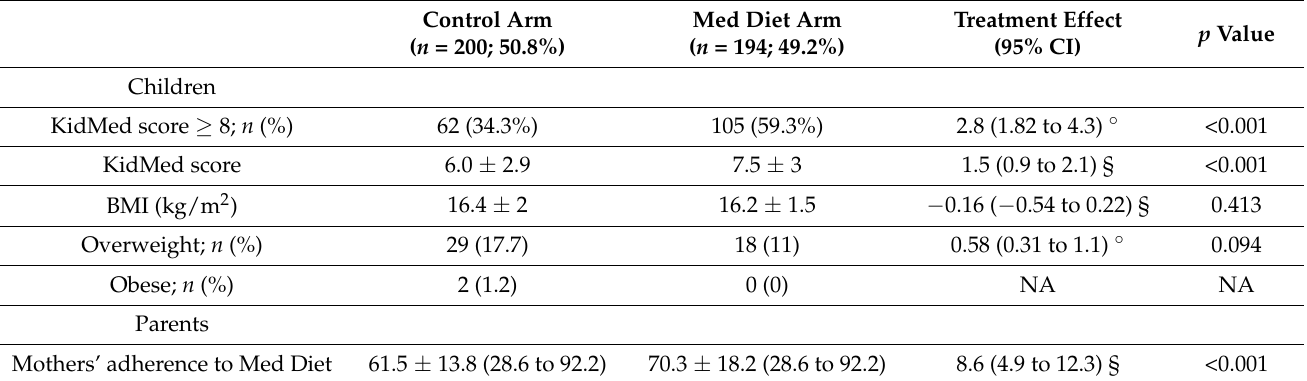
Table 2. Differences between groups in primary and secondary end points with respect to ITT popu- lation. Variables are described by mean ± standard deviation (min to max) or absolute frequencies